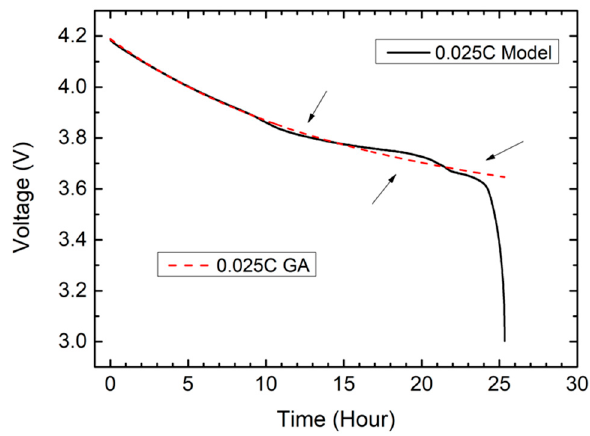
Figure 20. GA results (P brand 18650).